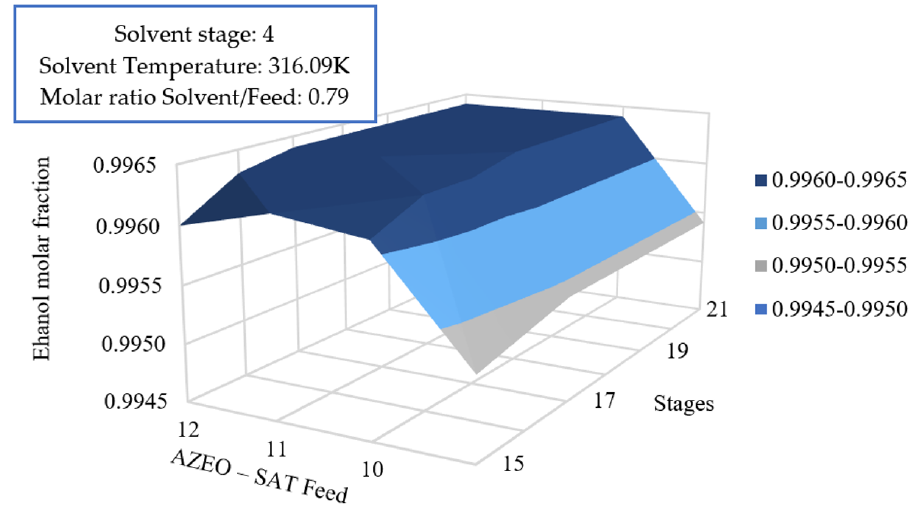
Figure 8. Variation of the azeotrope feed and the number of stages on ethanol